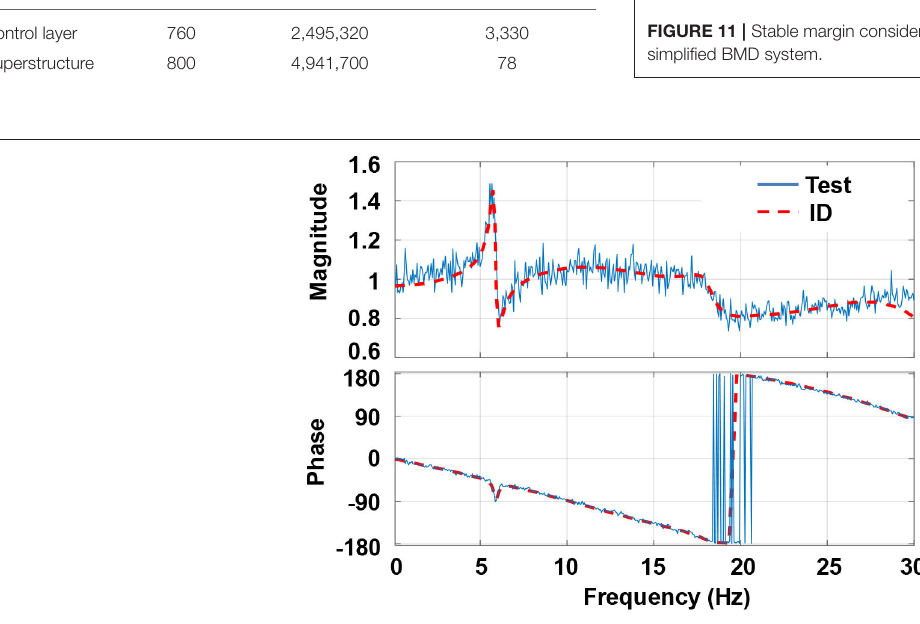
Frontiers in Built Environment |